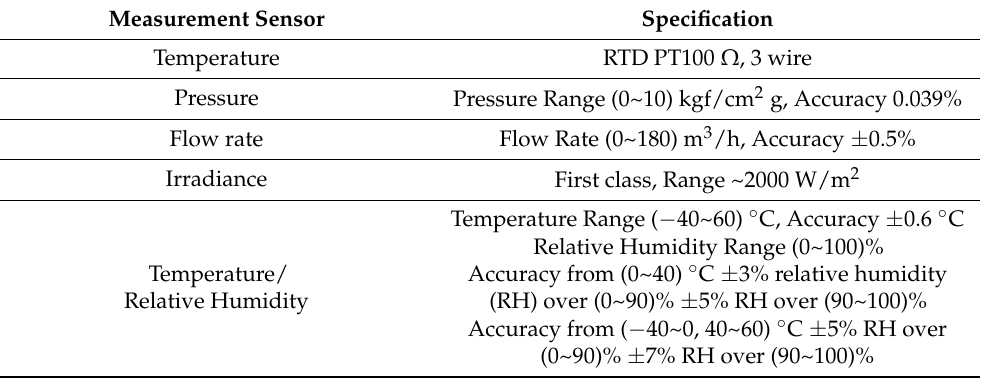
Table 1. Detailed information of measurement instruments.